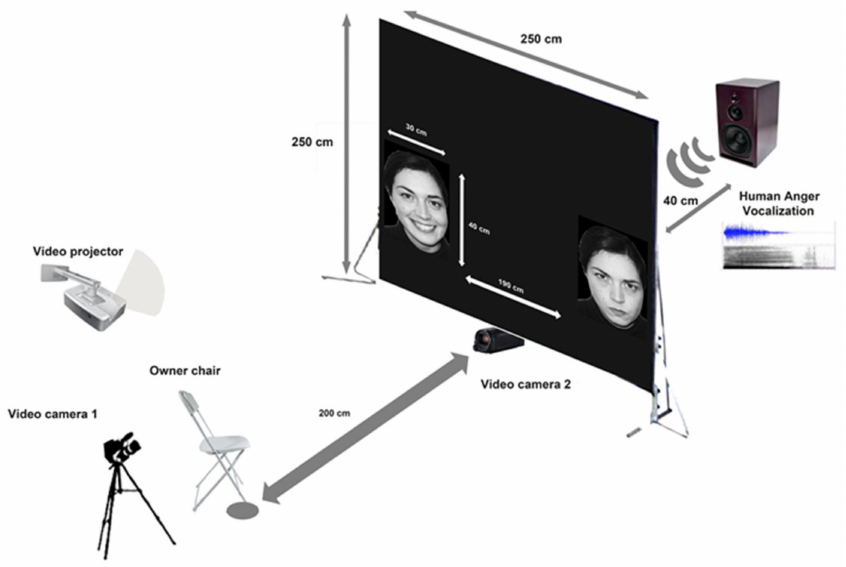
Figure 2. Schematic representation of the testing